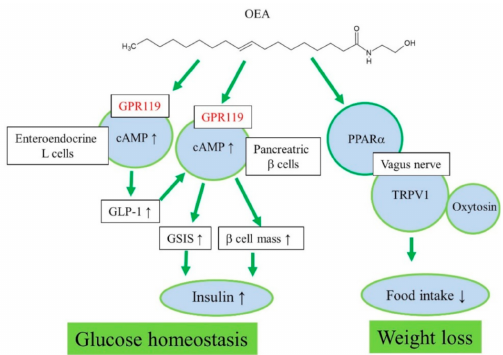
Figure 1. Proposed action mechanisms of OEA for regulation of glucose homeostasis and weight